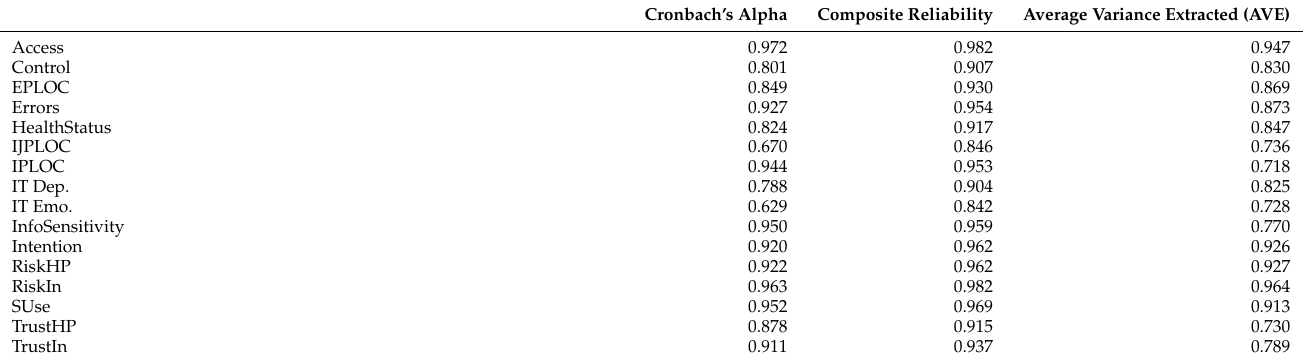
Table A7. Reliabilities of Multi-Item Constructs.